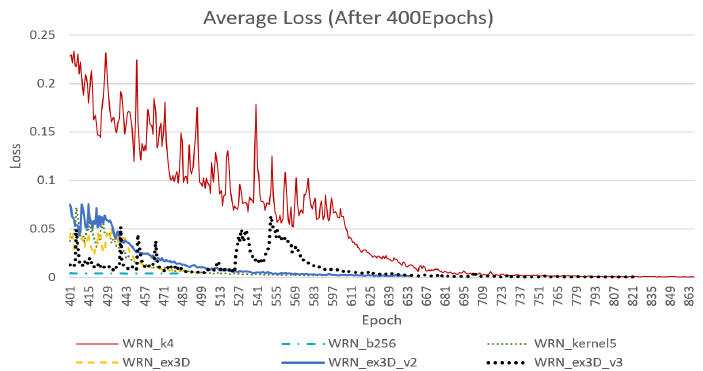
Figure 13. Terminal convergence results of average loss under the condition where the samples were randomly distributed between training and testing sets at a 5:5 ratio (after epoch 401).